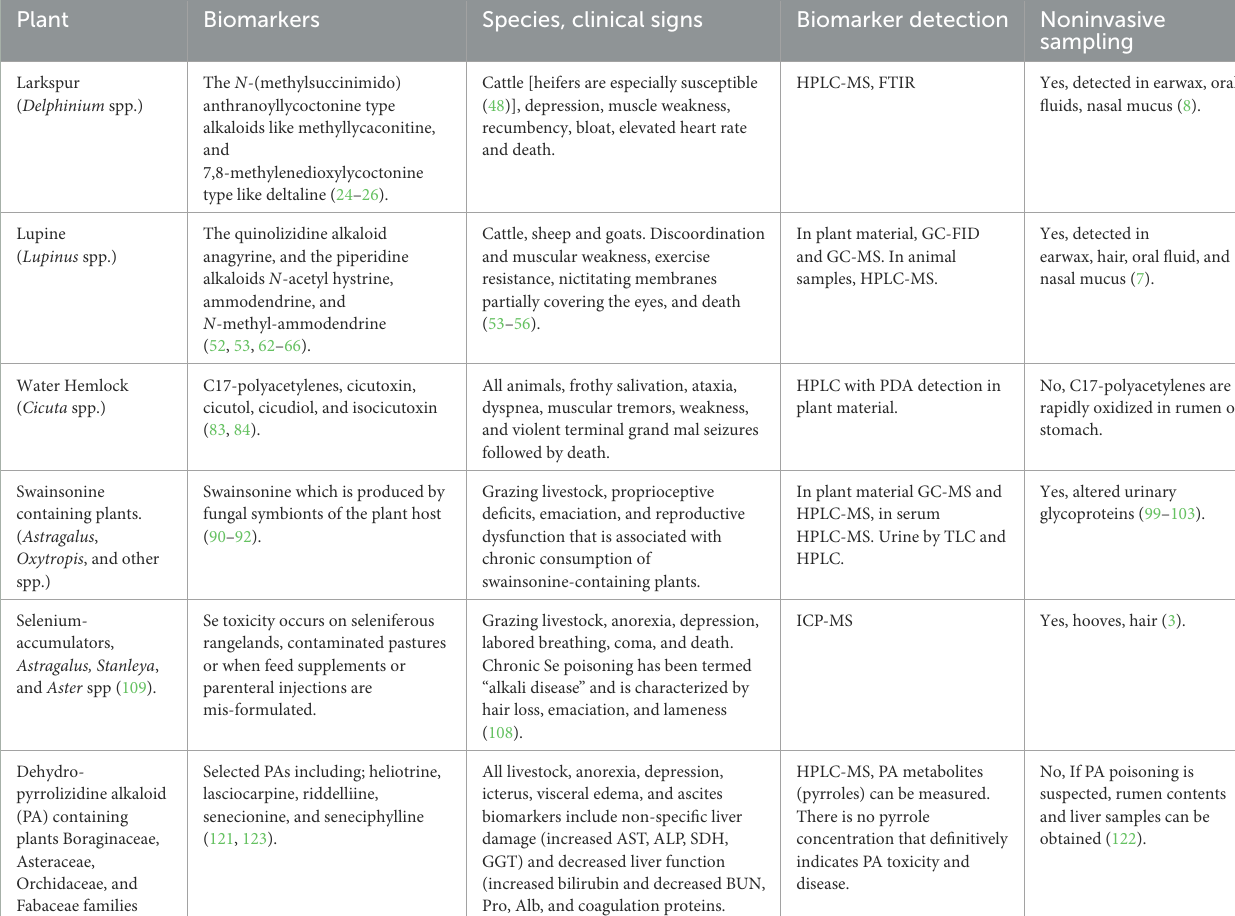
TABLE 3 Poisonous plants of Western North America, biomarkers, affected species, clinical signs, detection, and sampling.